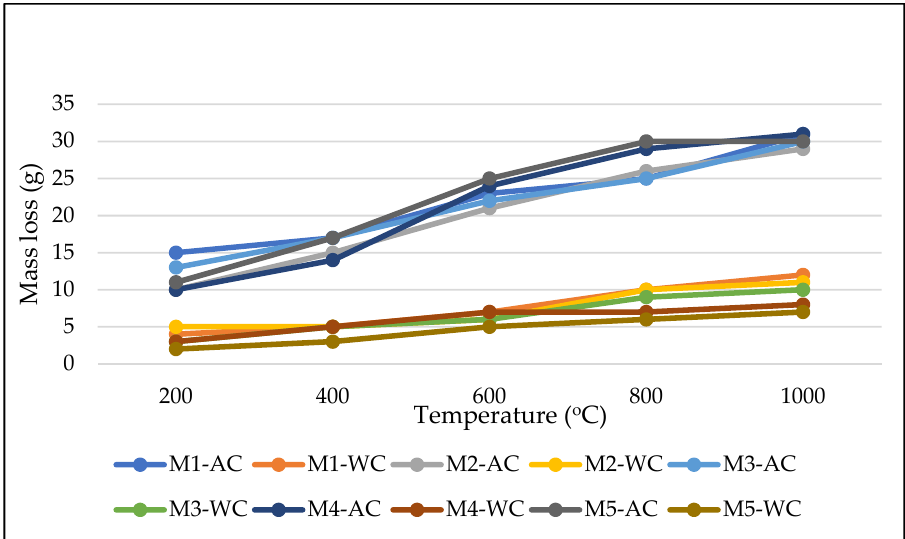
Figure 6. Mass loss of partial-water-cured samples at elevated temperatures (where AC is air cooling, and WC is water cooling).